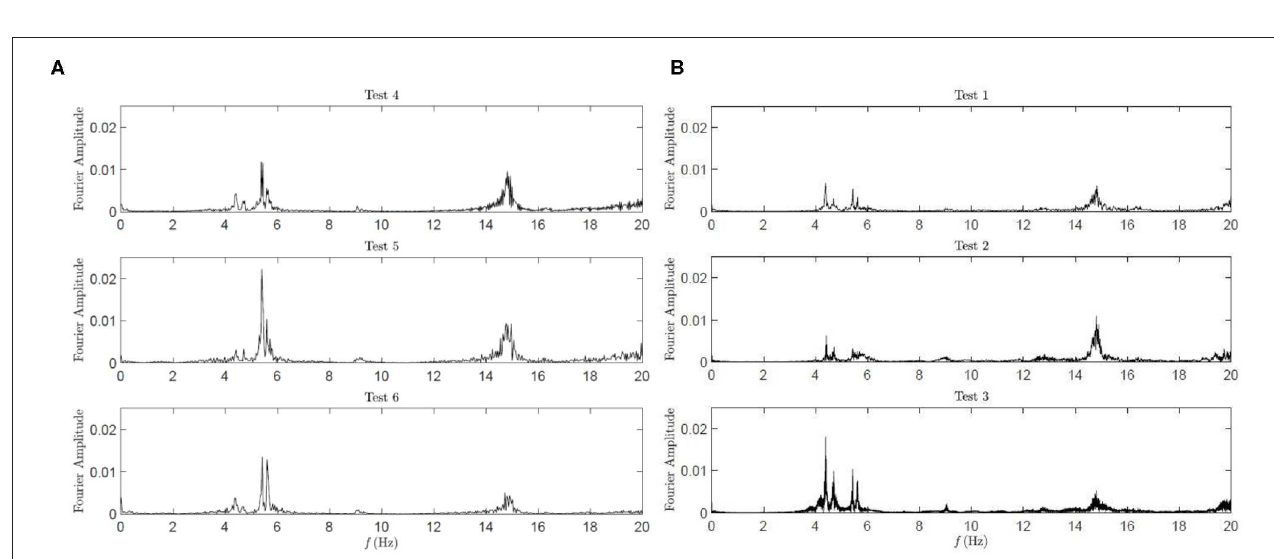
FIGURE 11 | Fourier spectra of the (A) measured free vibration data (B) measured vehicle data.